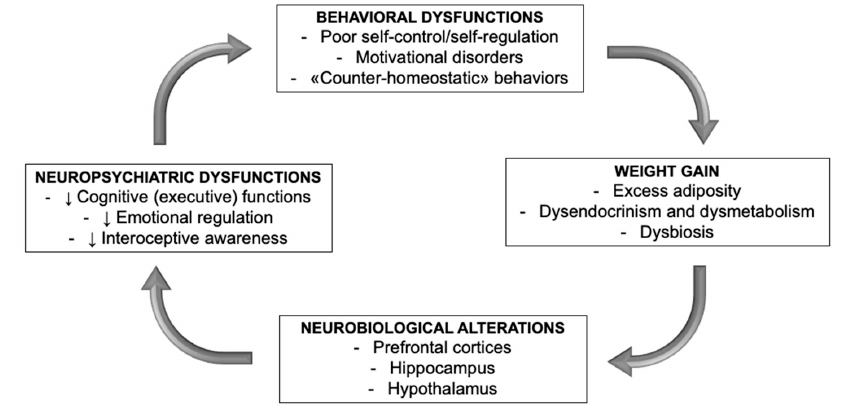
Figure 3. Obesity-associated neuropsychiatric dysfunctions, outlined elsewhere in the text, entail inadequate self-control and unhealthy behaviors, which lead to excessive, disordered eating and weight gain. In its turn, weight gain is accompanied by a whole complexity of pathobiological alterations, which aggravate the neuropsychiatric dysfunctions by engendering a neurofunctional and, subsequently, neuroanatomic damage.